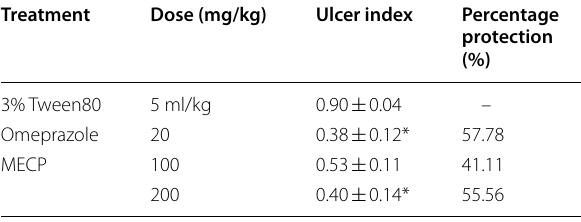
Values are expressed as mean relative to negative